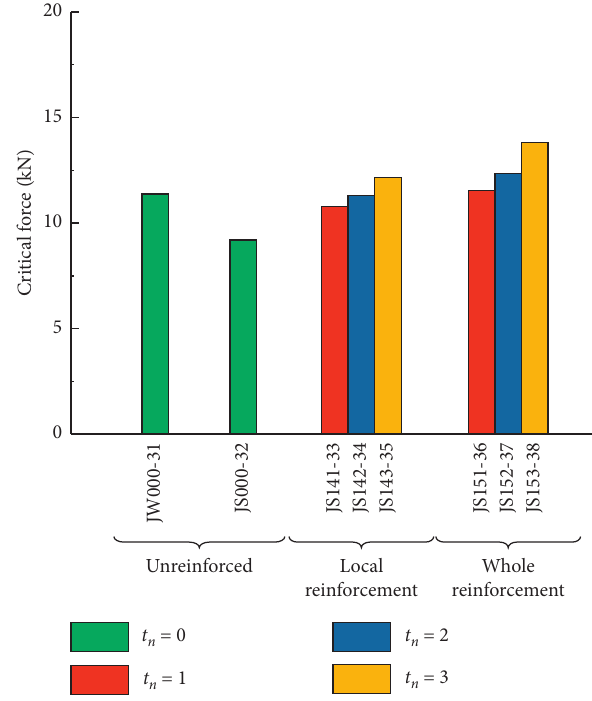
Figure 7: Influence of damage degree on the critical force in Group Figure 8: Influence of paste thickness of CFRP on the critical force in Group